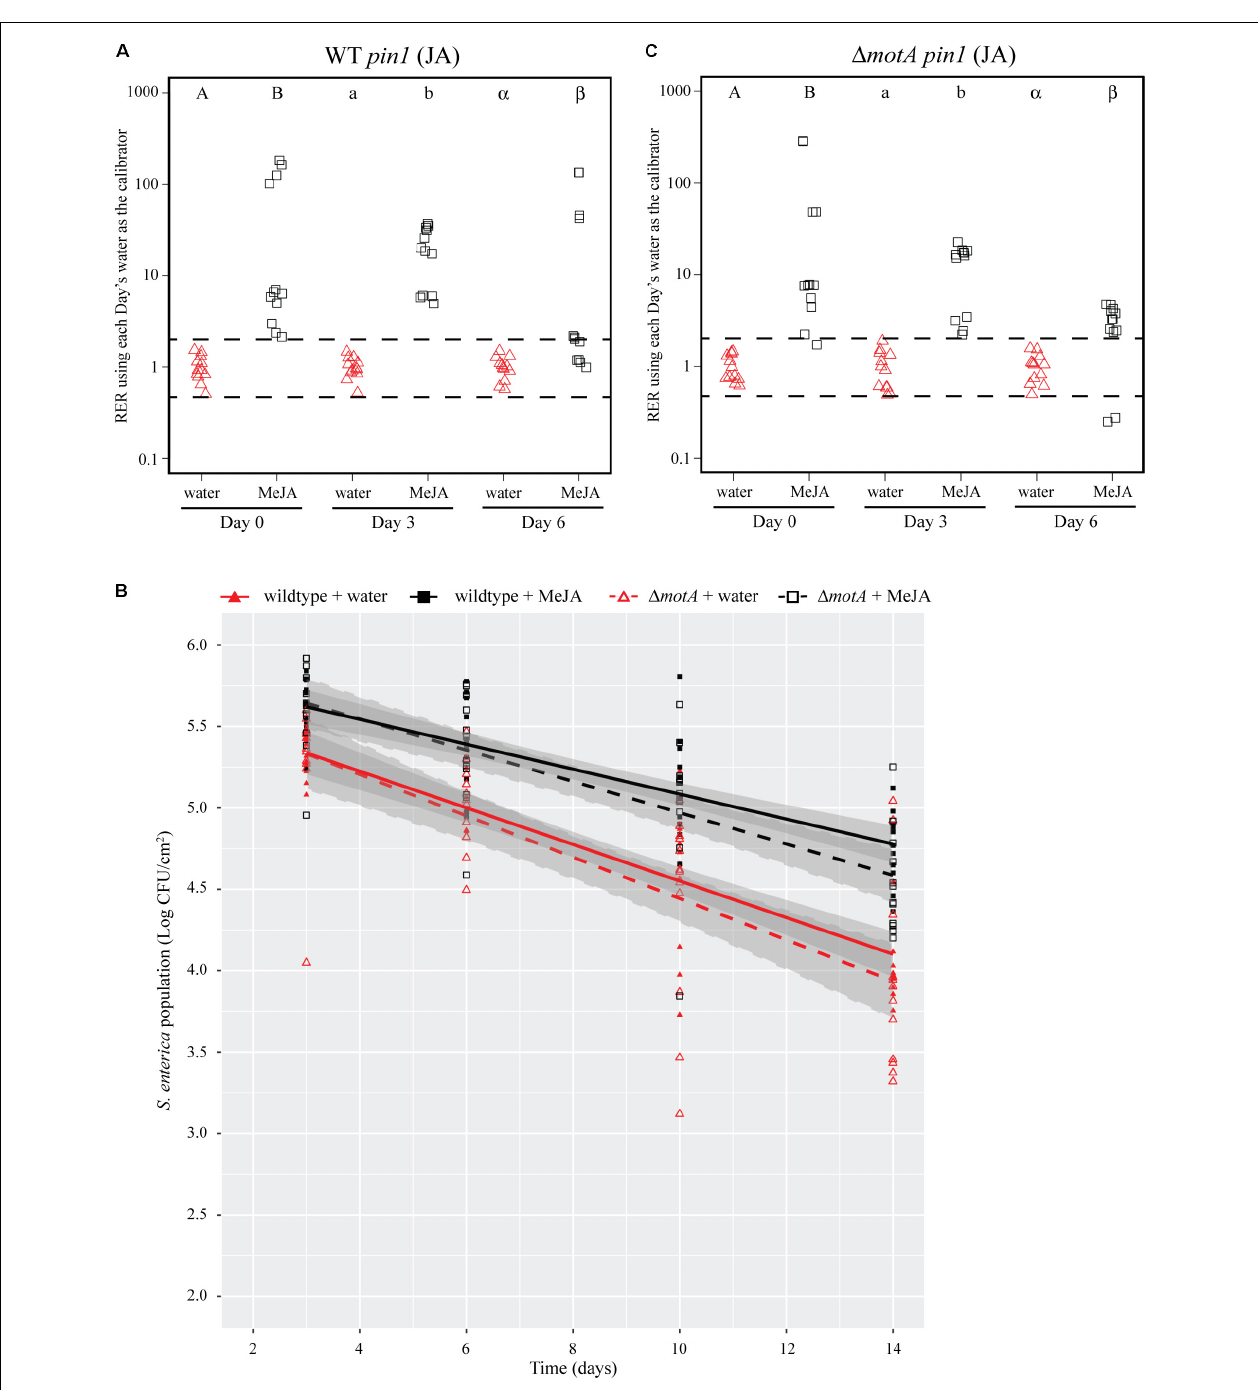
FIGURE 5 | Induction of the JA response with a chemical analog increases S. Typhimurium survival over time. (A,C) Plant pin1 gene expression was quantified at days 0, 3, and 6 post-inoculation with wildtype S. Typhimurium (A) or the motA ::Kan mutant (C) for plants sprayed with water (red triangles) or MeJA (black squares) and displayed as relative expression ratios (RER) using transcription on plants treated with water as the calibrator. The dashed line indicates a twofold change in transcription, and each symbol represents data collected from one tomato plant. Transcript levels were quantified from three biological replicates with samples taken from four plants per treatment per time point. Letters denote significant differences between treatments within a single time point ( P < 0.05). (B) Bacterial populations on leaves were monitored over time following either treatment with water (red triangles) or MeJA (black squares) 24 h prior to bacterial dip inoculation. All data points from three independent experiments were combined and presented as S. Typhimurium populations (log CFU/cm 2 ) over a 14-day period. Lines (red, solid: wildtype S. Typhimurium after water treatment; black, solid: wildtype S. Typhimurium after MeJA treatment; red, dashed: motA ::Kan after water treatment; black, dashed: motA ::Kan after MeJA treatment) correspond to a linear regression model, and shaded areas correspond to the respective 95% confidence interval.